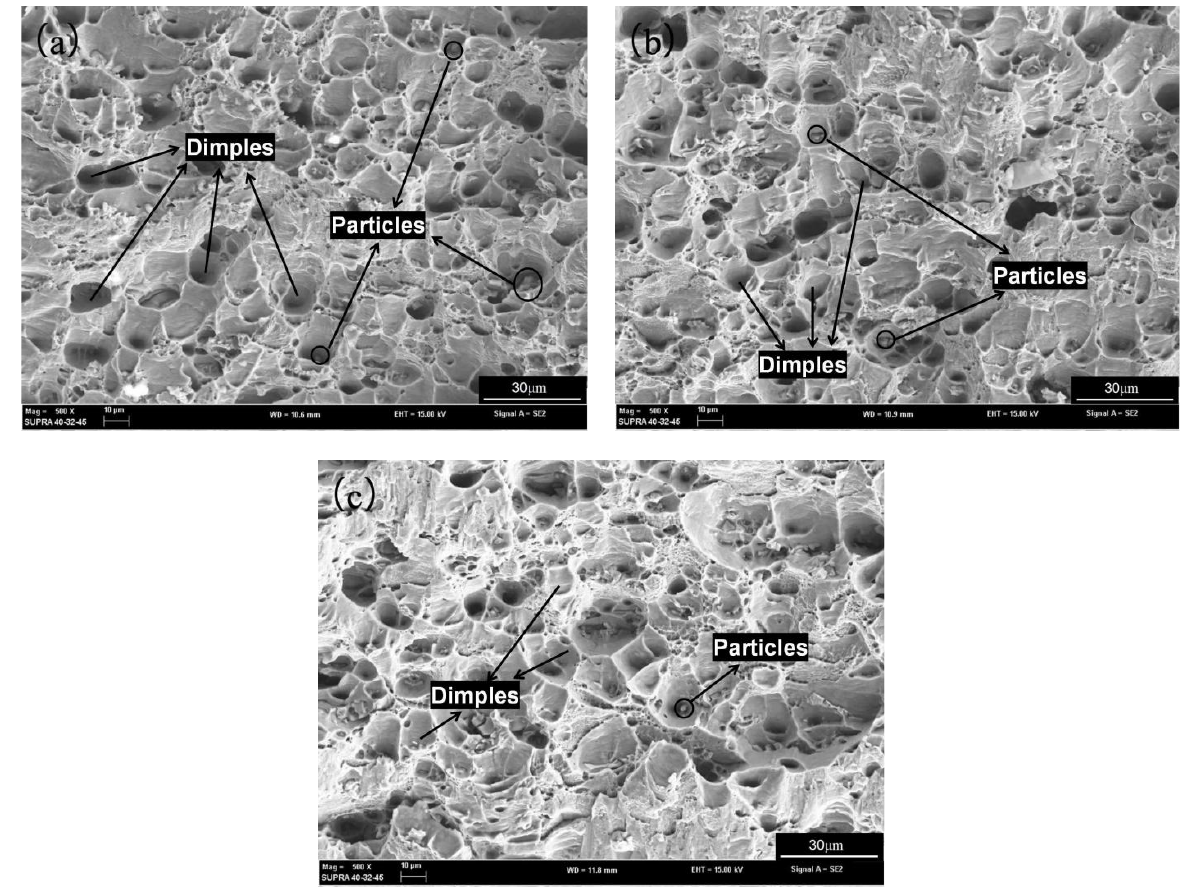
Figure 11. Fracture morphology of FSW joints. ( a ) tool pin A; ( b ) tool pin B; ( c ) tool pin C.